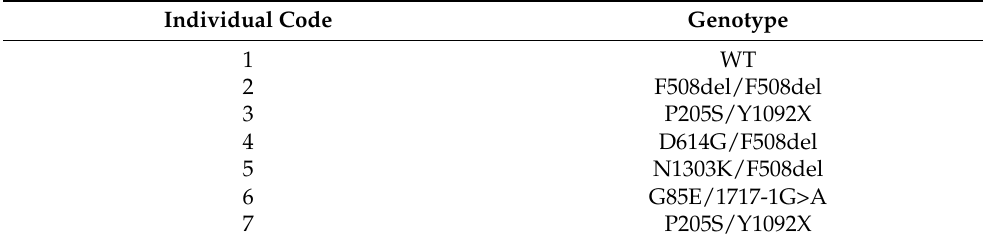
Table 1. Individuals that participated in the study and their respective